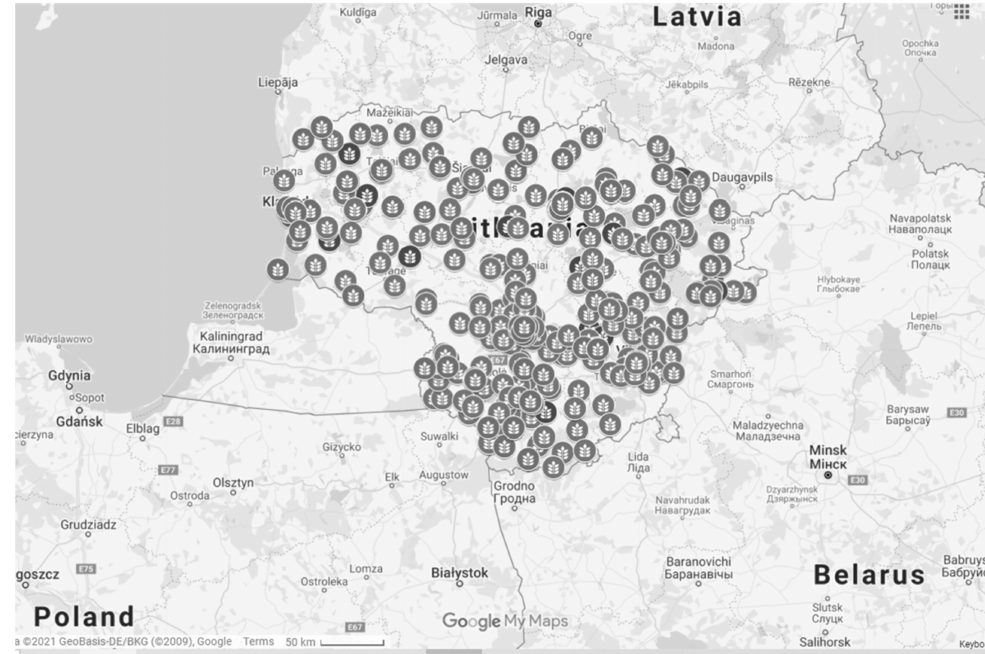
Figure 1. Distribution of farmers who offered their products via the network “Village to Your Home” in Lithuania in December 2021